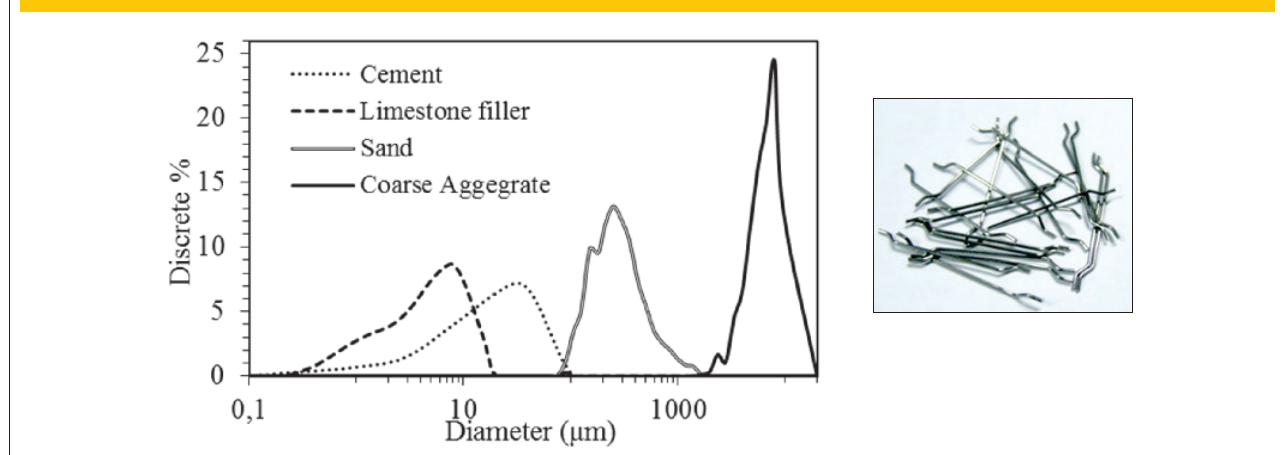
Figure 2 – Particle size distribution of the materials and fiber used in the